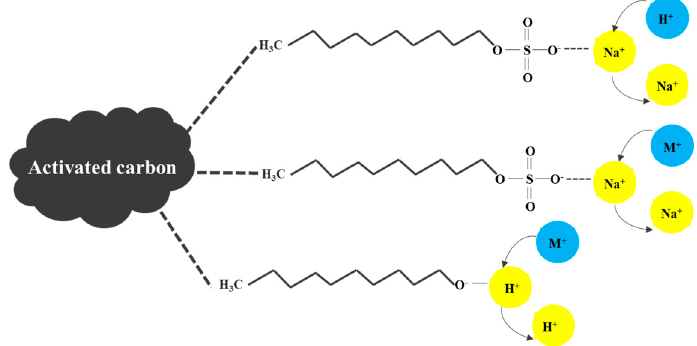
Figure 3. The chemical adsorption between MB dye and the surface functional groups on sodium lauryl sulfate (SLS)-C.